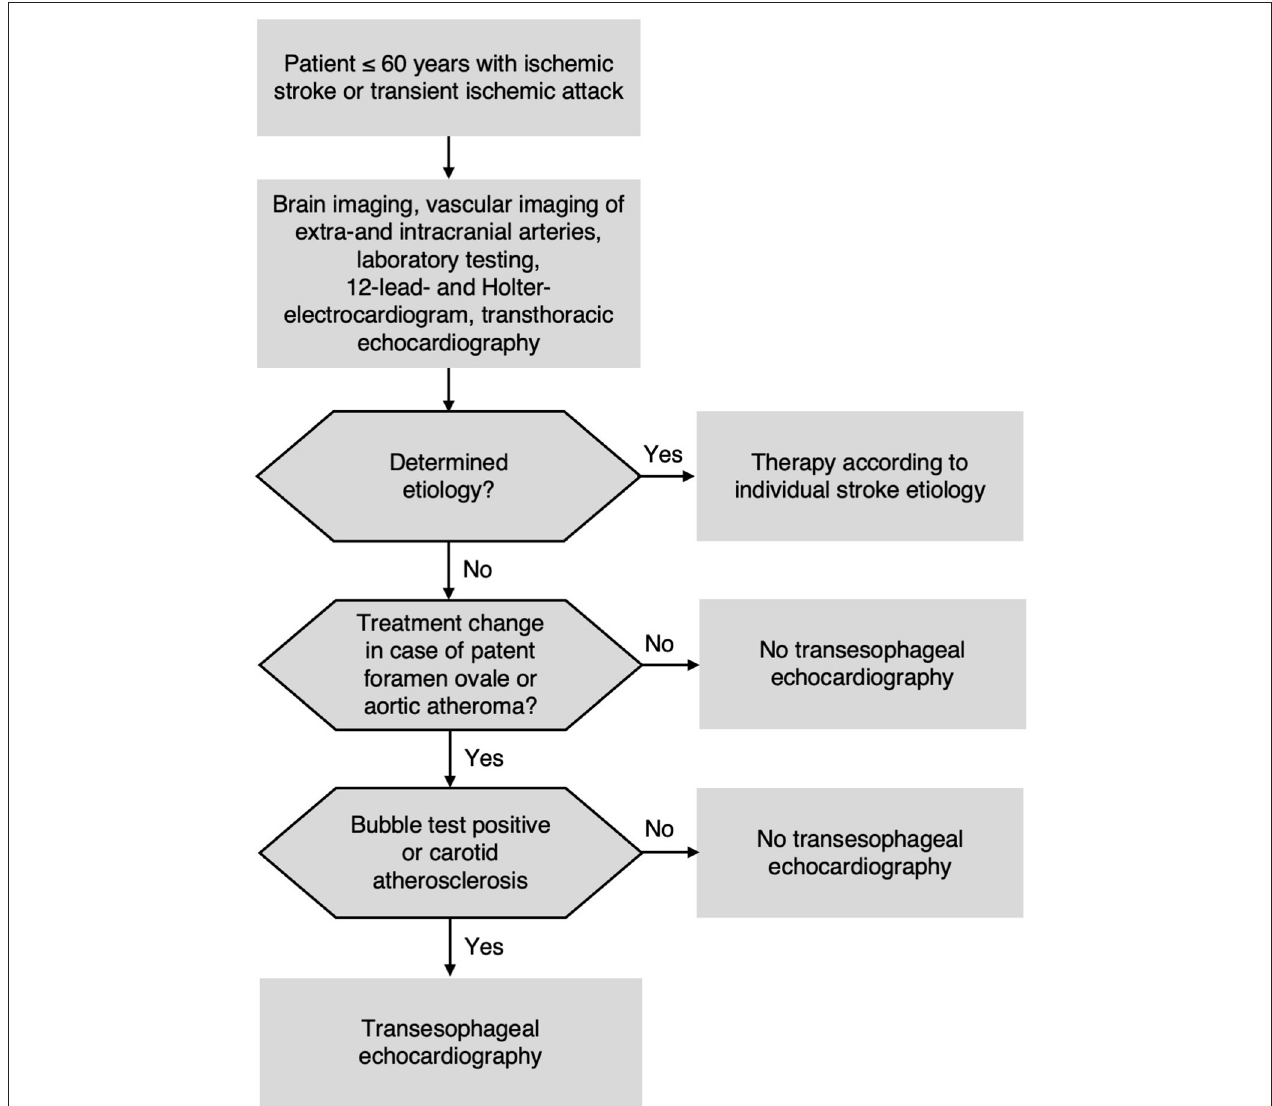
FIGURE 3 | Proposed diagnostic algorithm for patients ≤ 60 years with acute ischemic stroke or transient ischemic attack